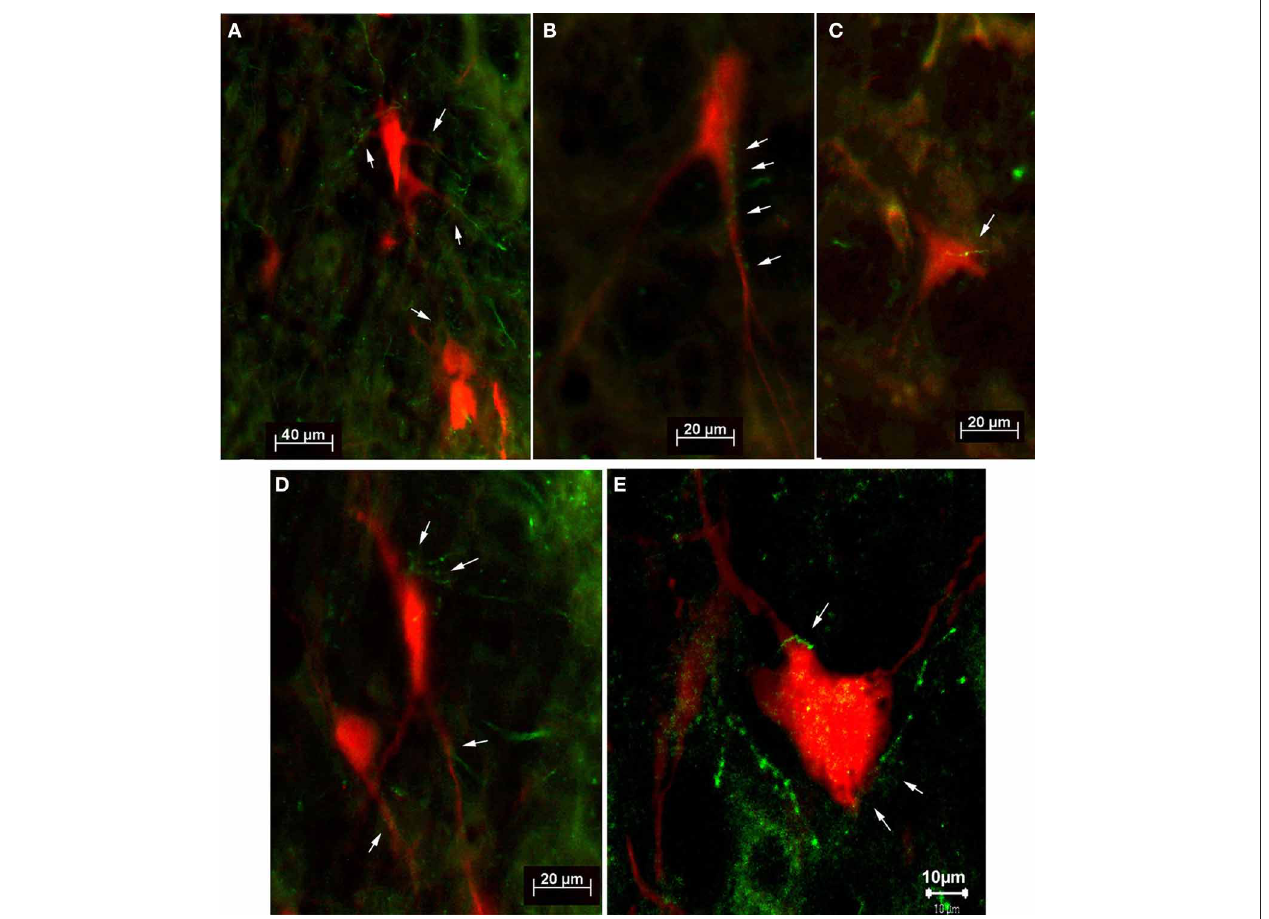
FIGURE 6 | Fluorescence photomicrographs (A–D) and confocal micrograph (E) of retrogradely labeled neurons (red) with adjacent tectofugal fibers and varicosities (green) from case SC14 (A,B,D,E) and from case SC16 (C). The neurons were located in the n. reticularis